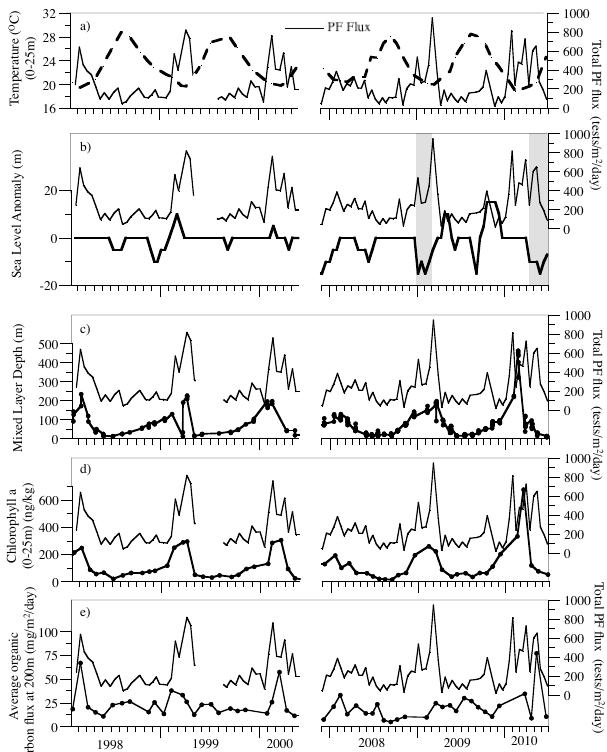
Figure 3. Temporal changes in environmental parameters measured at the BATS site in relation to total planktonic foraminiferal flux in the 1500m OFP trap (thin, black line): (a) sea surface temperature (0–25m), (b) sea level height anomaly; grey bars indicate periods when productive cyclonic eddies influenced the site, (c) mixed layer depth, (d) chlorophyll a concentration (0–25m average), and (e) av- erage organic carbon flux at